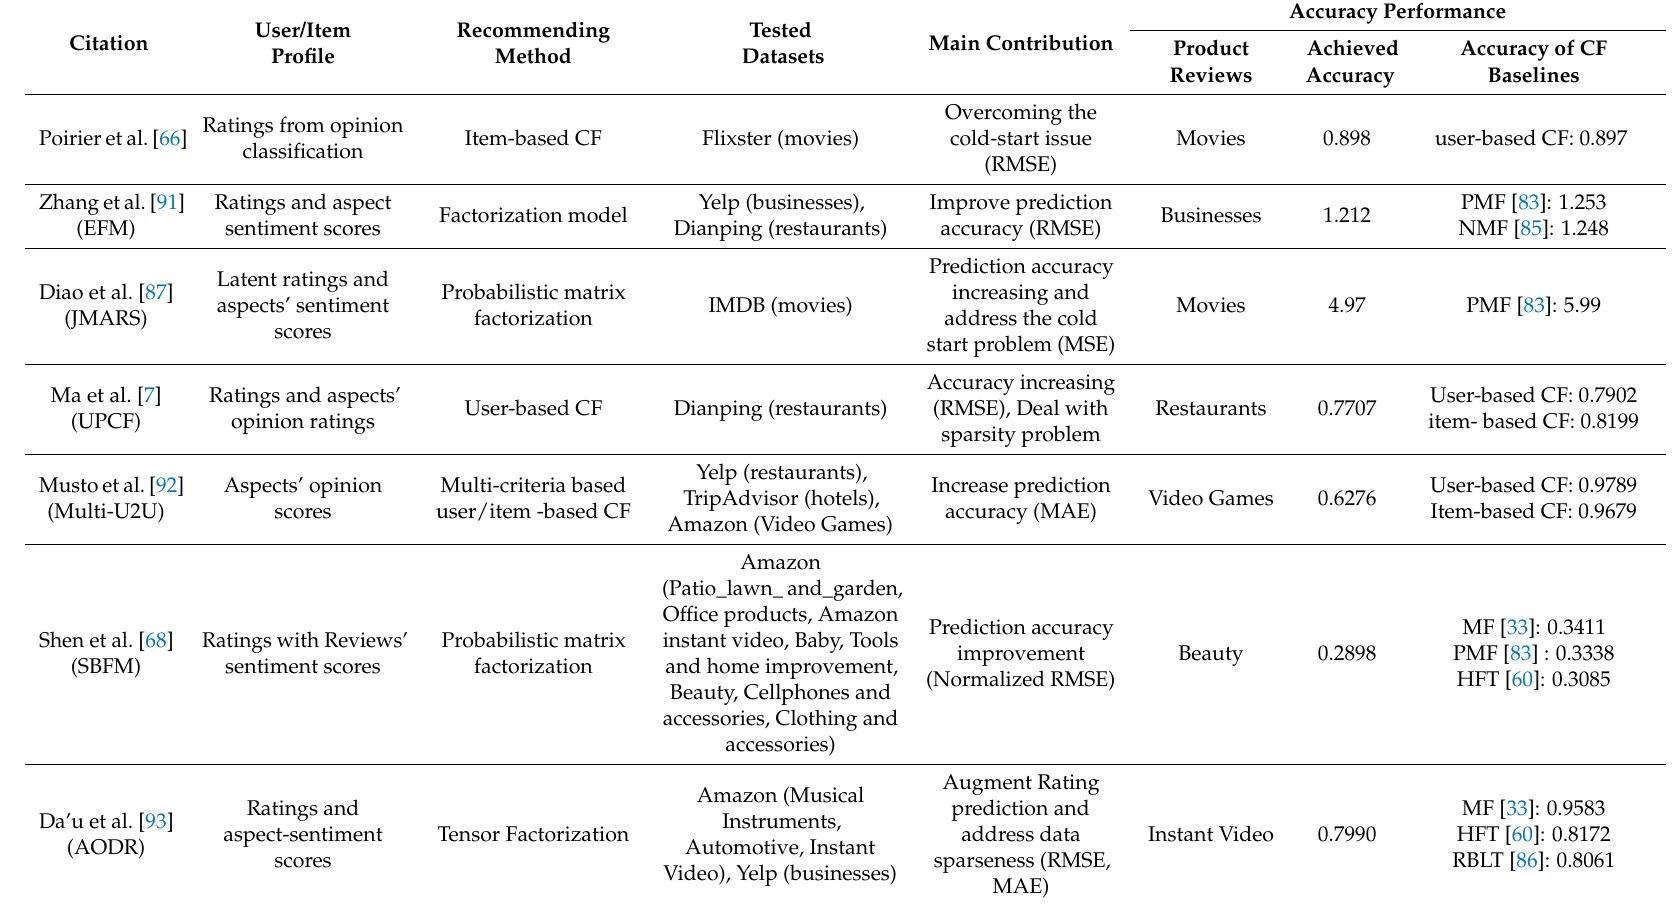
Table 5. Related works on techniques based on review